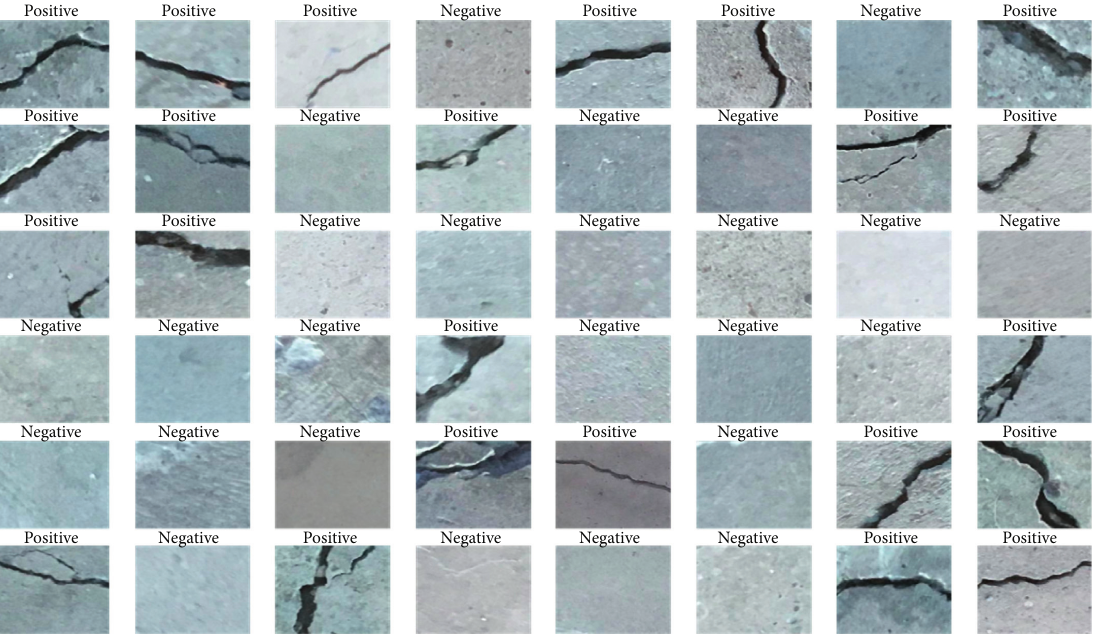
Figure 7: Validation